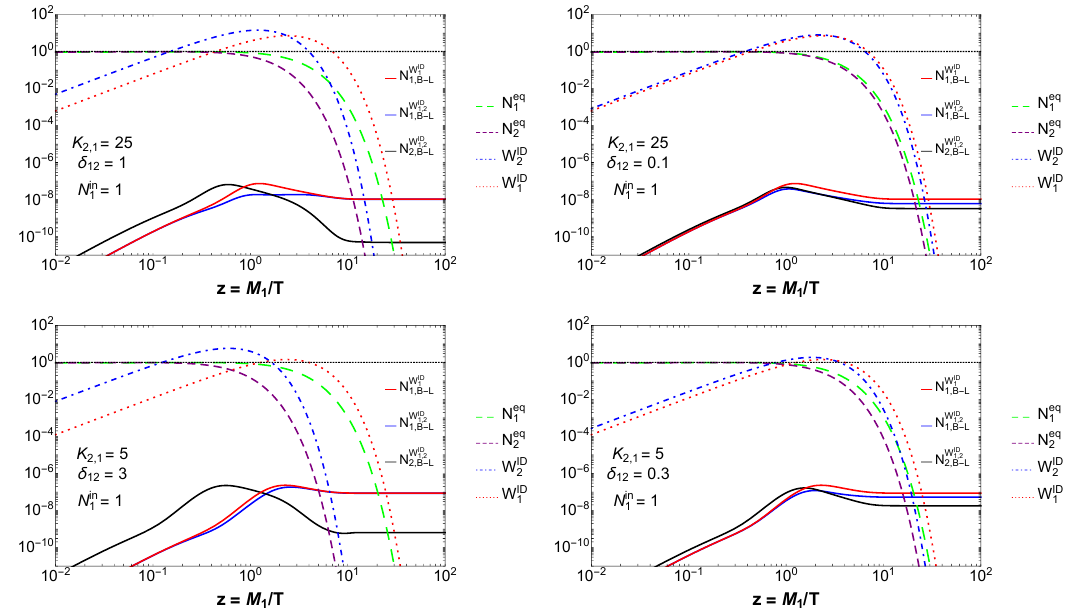
Figure 1 . Top left: N B (cid:0) L as a function of z = M 1 =T for the decay parameters K 1 = K 2 = 25 (the j j other relevant quantities, e.g., N eq , W ID etc., are mentioned on the right side of each (cid:12)gure). Solid 1 1 red line shows N B (cid:0) L for a pure N 1 dominated scenario. The solid blue line shows the asymmetry j j generated by N 1 , for (cid:14) 12 = 1, subjected to both N 1 and N 2 washout, given by W ID respectively. 1 ; 2 The solid black line shows N B (cid:0) L , generated by N 2 subjected to W ID washout. Top right: for the 1 ; 2 same value of the decay parameters we generate similar plots for (cid:14) 12 = 0 : 1. Bottom panel shows similar plots as those in the top panel for (cid:14) 12 = 3 (left) and (cid:14) 12 = 0 : 3 (right), for K 1 = K 2 = 5. by N is signi(cid:12)cantly washed out by N (showed in black). This is due to the fact 2 1